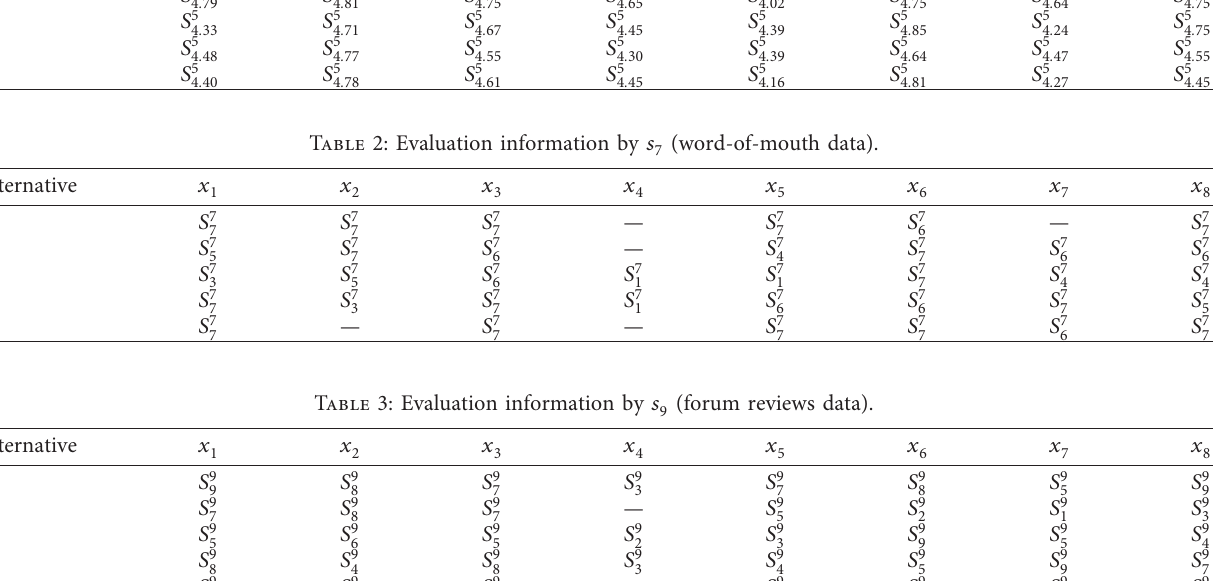
Table 1: Evaluation information by s